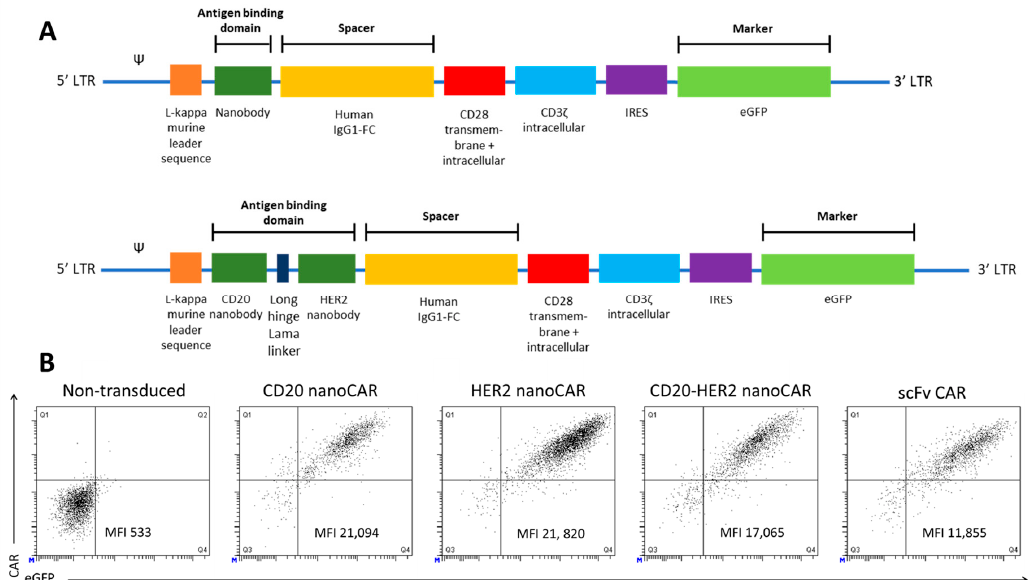
Figure 1. Nano chimeric antigen receptorS (CARs) are stably expressed on T cells at levels comparable to an scFv based CAR. ( A ) Scheme of the second generation nanoCAR constructs used to retrovirally transduce T cells. The antigen-binding domain is linked to the constant regions of the Fc tail of the human IgG1 antibody heavy chain, which is linked to the transmembrane and intracellular CD28 and intracellular CD3 ζ chain. ( B ) Human peripheral blood T cells were activated and retrovirally transduced to express a nanoCAR. CAR expression was measured by flowcytometry on eGFP + sorted cells after staining with a phycoerythrin (PE)-conjugated human anti-IgG antibody, which binds the spacer domain in the CAR. Non-transduced and scFv-CAR transduced T cells were used as controls. The figure is representative of five different healthy donors.